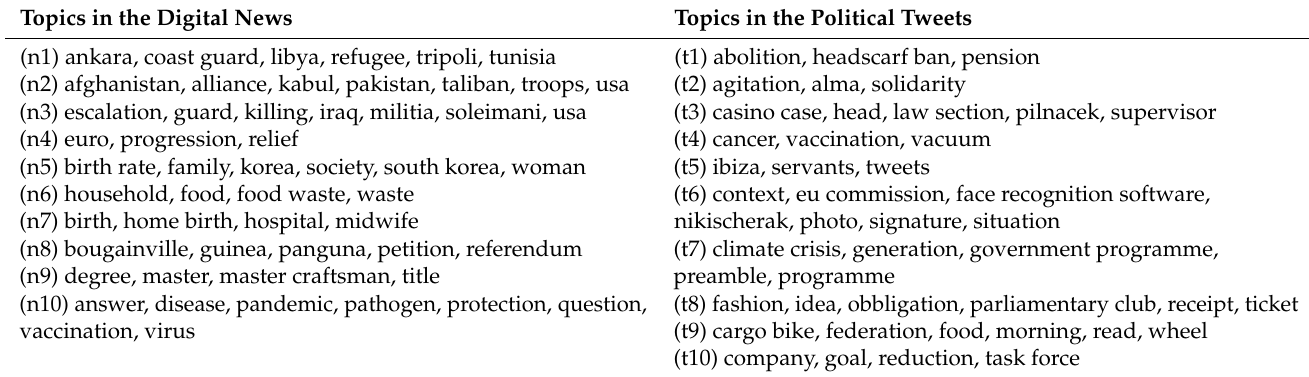
Table 4. The topics extracted from the corpus of digital news and the corpus of digital tweets in the application of our